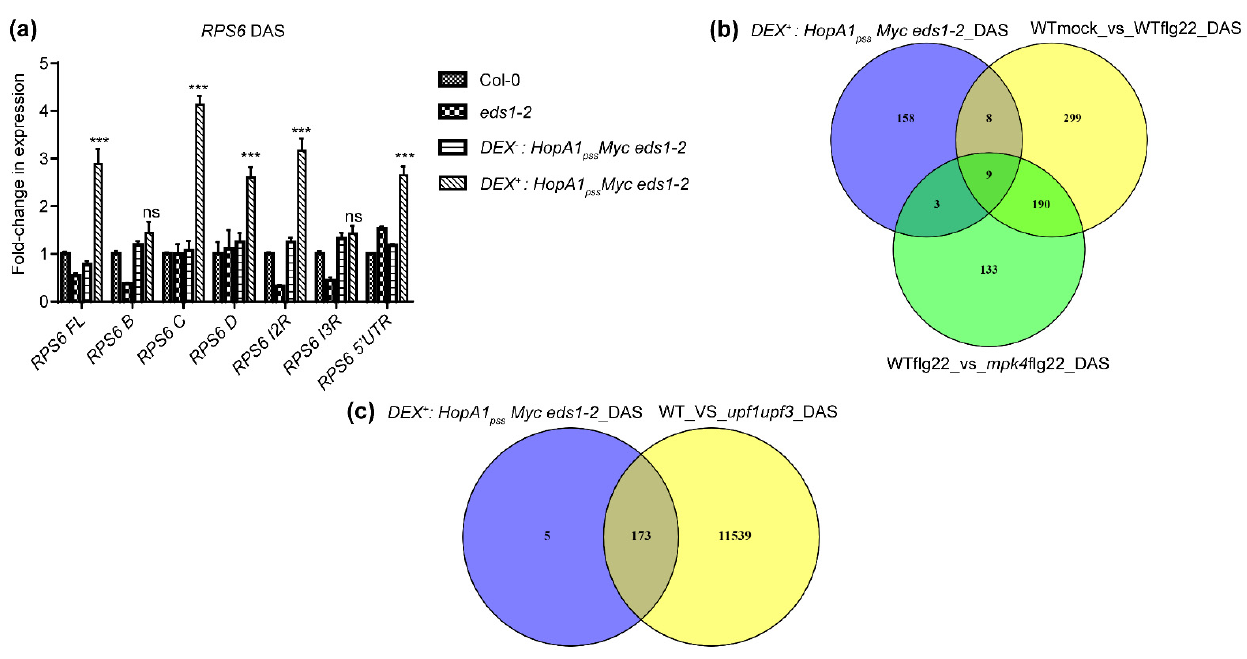
Figure 4. Alternative splicing of transcripts are perturbed during ETI HopA1pss -like responses. ( a ) Expression level of splice variants of RPS6 in Col-0, eds1-2 , Dex − and Dex + HopA1 pss -expressing transgenic plants. Data represent mean values from triplicate samples (± SD) and are indicated as fold-change relative to Col-0. Pairwise Student’s t -test was used for statistical analysis (*** p < 0.001). Venn diagram showing overlap between unique differentially alternatively spliced (DAS) transcripts in early ETI HopA1pss to ( b ) flg22-treated WT (Col-0) or mpk4 plants (from Bazin et al., 2020) and ( c ) upf1 upf3 mutant (from Dreshel et al., 2013).